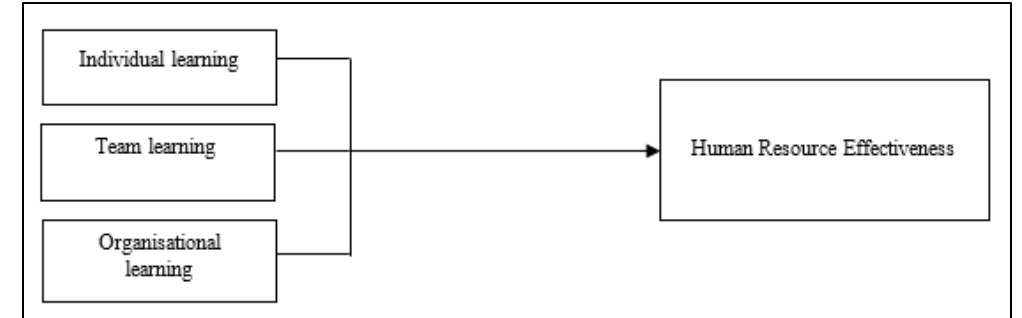
Fig. 1. Conceptual model on the dimensions of learning organization and HR effectiveness Source: Own